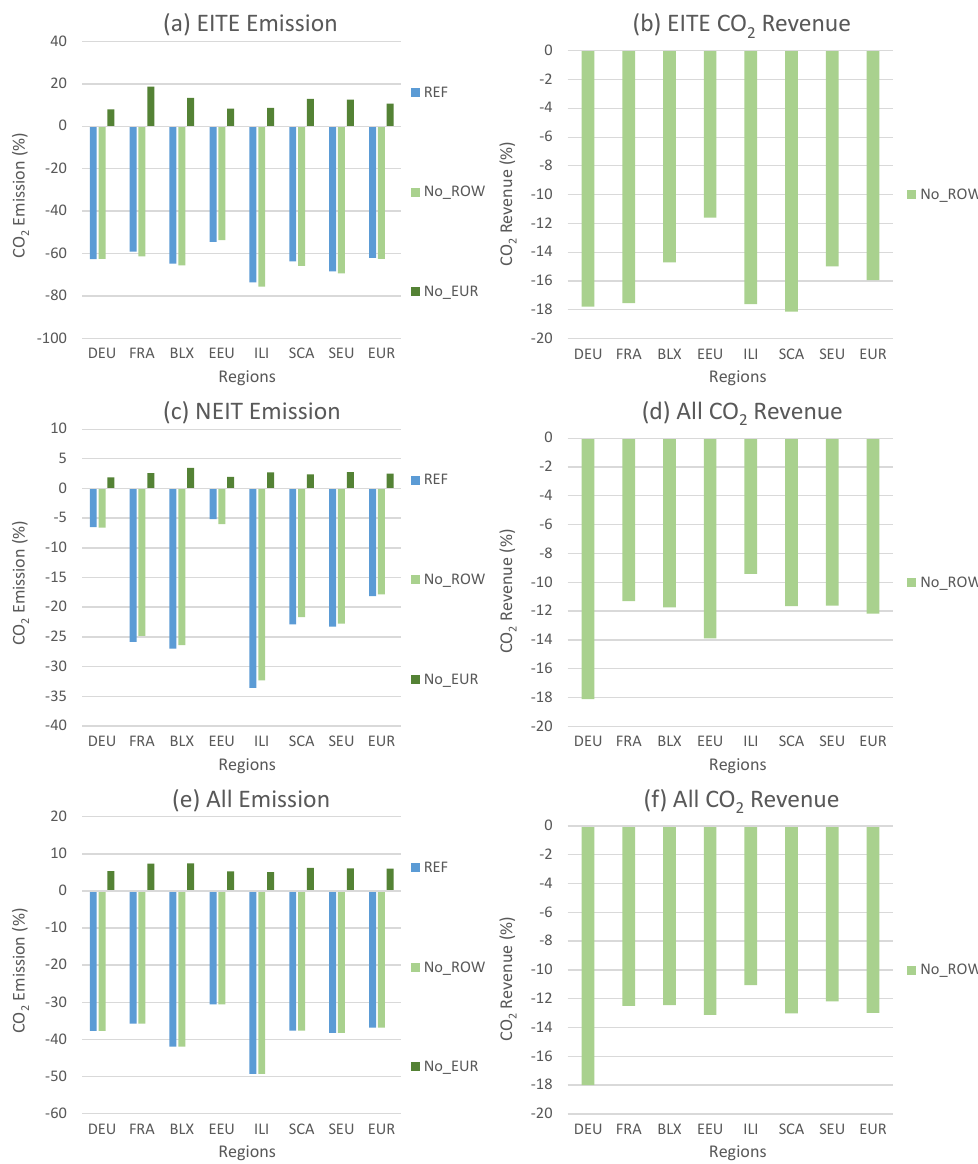
Figure 12. Percentage change in emission and CO 2 revenues in EITE, NEIT, and ALL sectors for different scenarios using the IEO